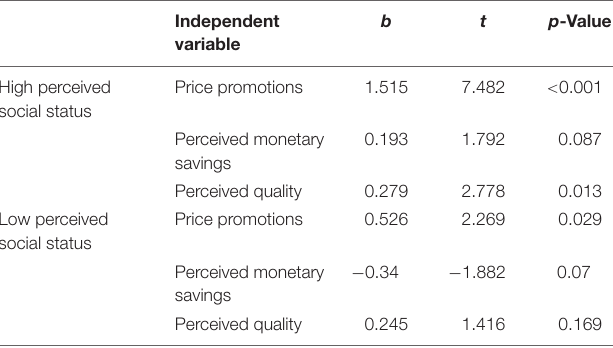
TABLE 3 | The LMM analysis results for the groups of high perceived social status and low perceived social status. Independent b p variable